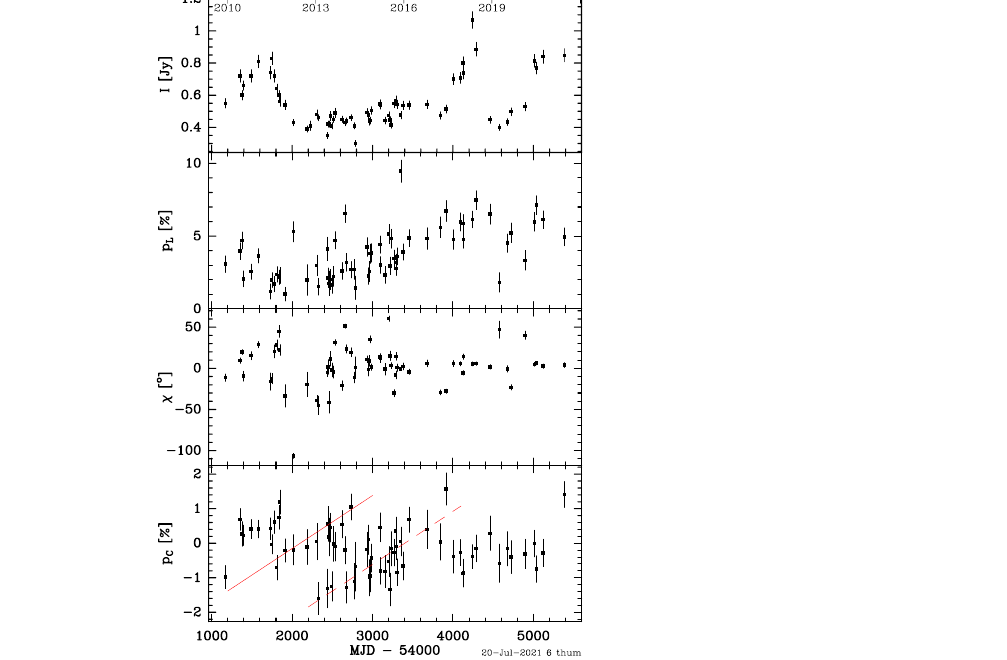
Figure 1. The POLAMI database product for the BLLac object 3C 66A at 3mm wavelength. The total flux ( I ), linear polarization degree ( m L ), linear polarization angle ( χ ) and circular polarization ( m C ) measurements (top to bottom) are shown for our POLAMI observations from the start until June 2021. The two red lines overlaid on the m C data illustrate the m C trains discussed in the